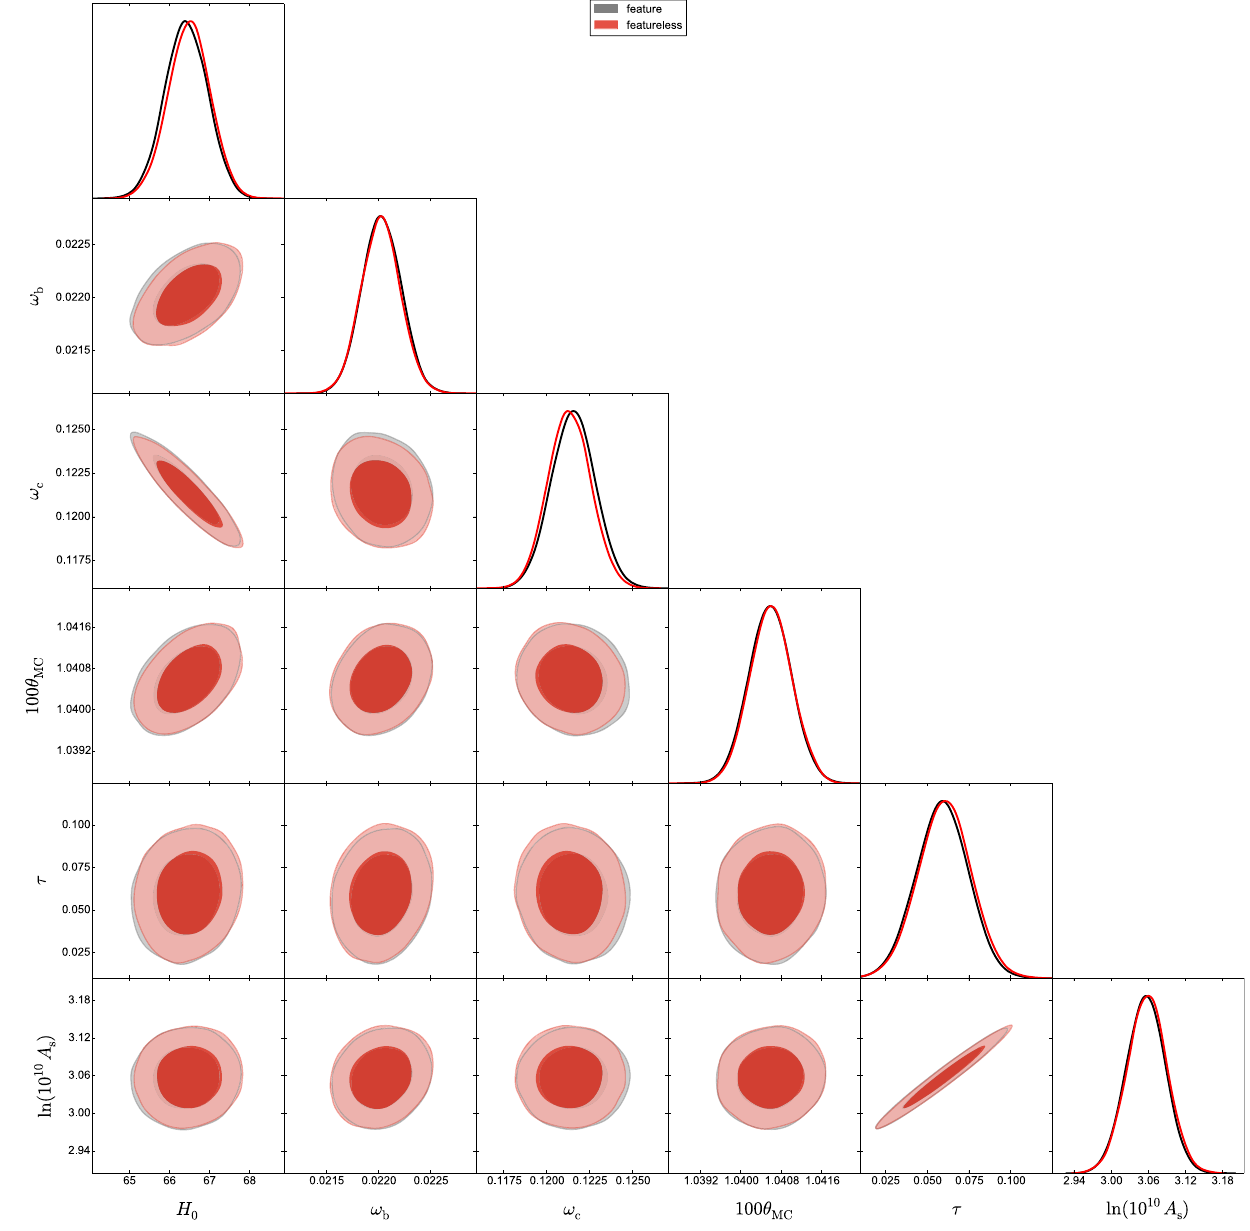
Fig. 5 A comparison between the model with and without features is given for the parameters H 0 , ω b , ω c , θ , τ and ln ( 10 10 A s ) . All the results are obtained considering the Planck low- (cid:14) +high (cid:14) data combina-